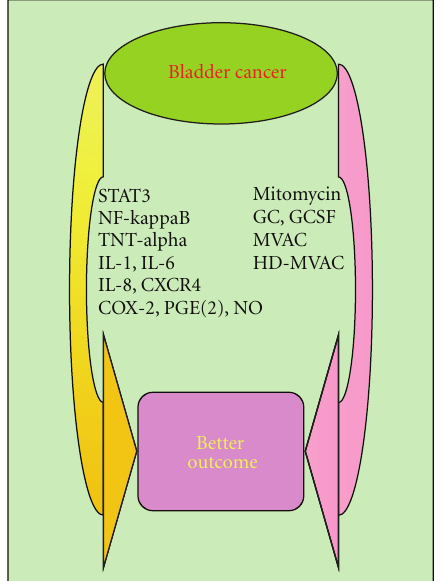
Figure 2: Modulating inflammatory pathways potentially enhance chemotherapy of bladder